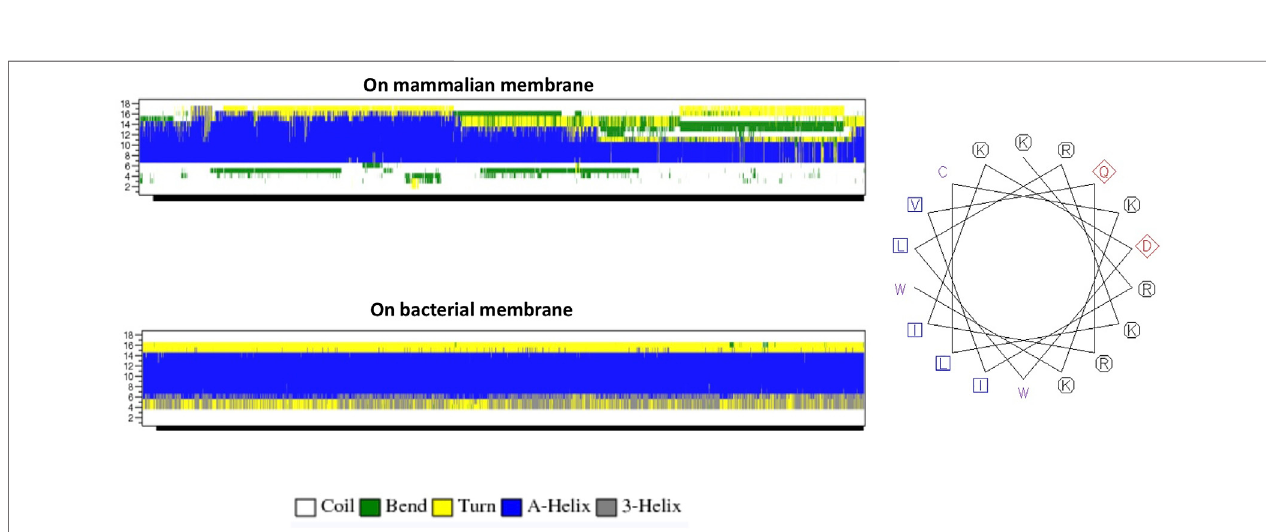
FIGURE 5 | (A) Secondary structure evolution of CaD23 during the molecular dynamics (MD) simulations. CaD23 adopts a partially alpha-helical structure on the mammalian membrane compared to a highly alpha-helical structure on the bacterial membrane. (B) The helical wheel plot of CaD23. Blue and purple letters represent hydrophobic residues, red letters represent negatively charged acidic residues, and black letters represent positive charged basic residues.